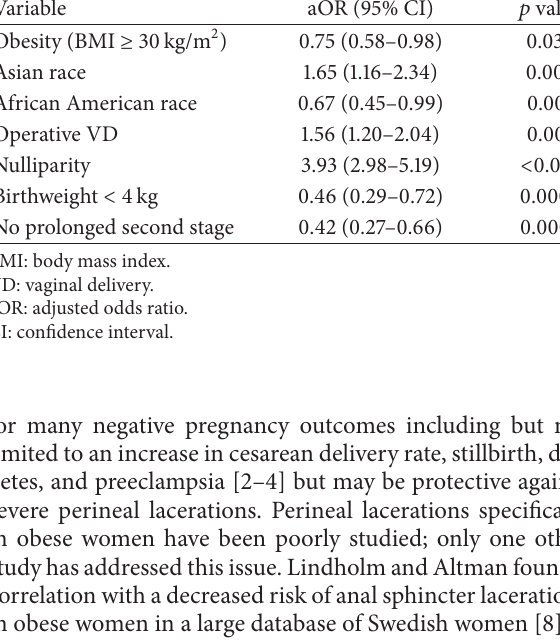
Table 1: Demographics and clinical characteristics of the study sample ( 𝑛 = 1210 ).